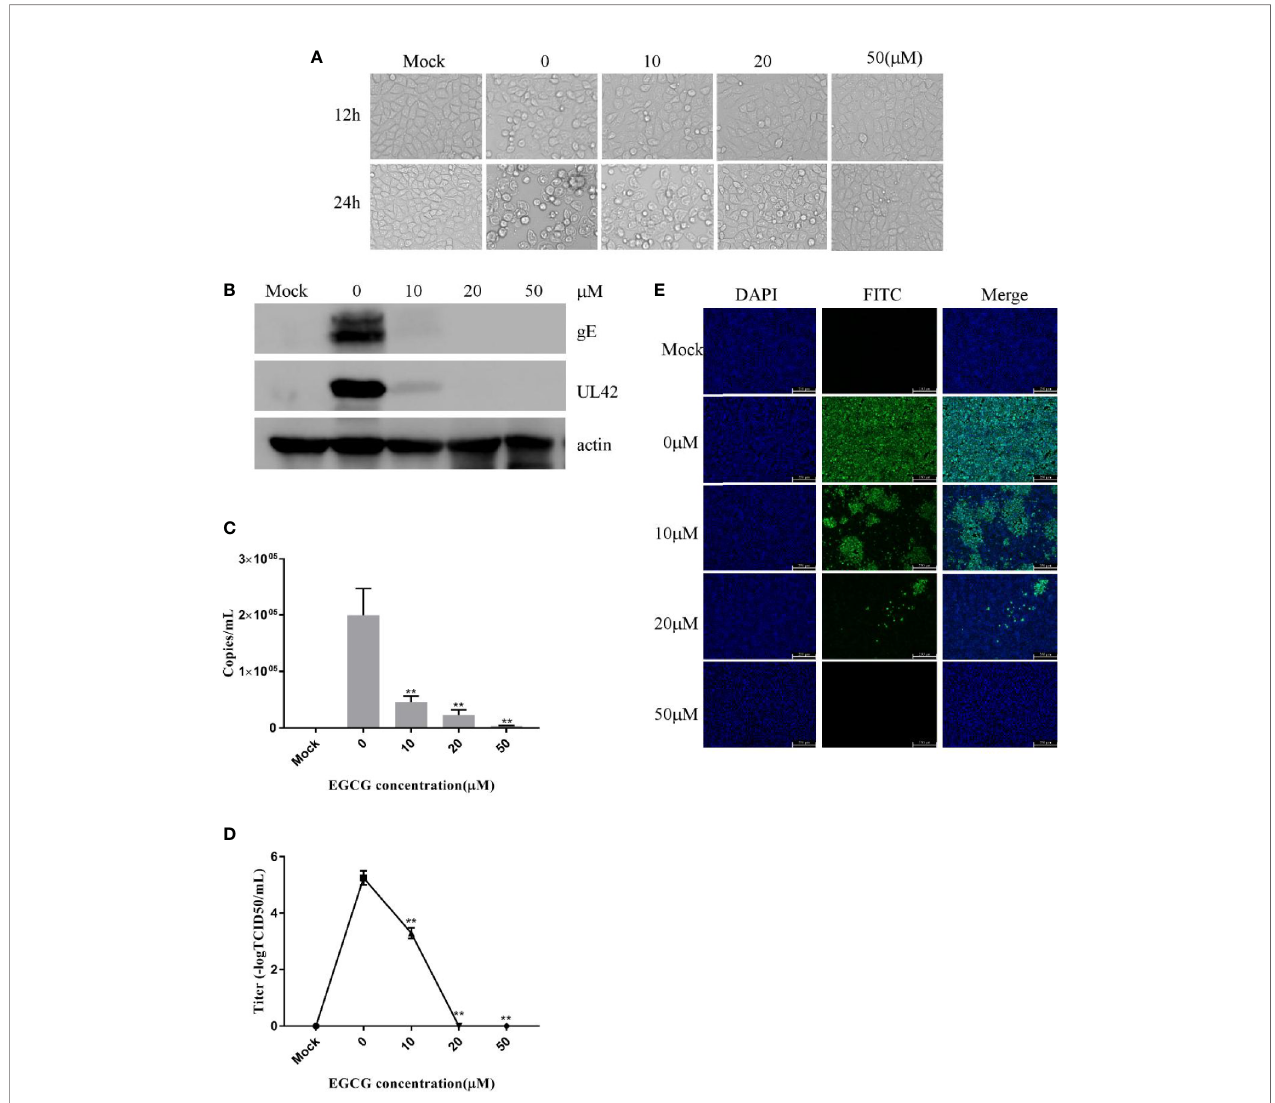
FIGURE 1 | ( – )-Epigallocatechin-3-gallate (EGCG) inhibited pseudorabies virus (PRV) infection in PK15 B6 cells. (A) Infected cells treated with 10, 20, or 50 m M EGCG for 12 or 24 h, showing changes in cell morphology. (B) PK15 B6 cells were pretreated with 10, 20, or 50 m M EGCG for 1 h before being infected with PRV XJ5 (MOI=0.1), then infected cells cultured with 10, 20, or 50 m M EGCG. At 24 hpi, gE, UL42 and b -actin proteins were detected by Western blot, (C) Viral DNA copy numbers were quanti fi ed by qRT-PCR. (D) Virus titer was evaluated by 50% tissue culture infective dose (TCID 50 ) and (E) immuno fl uorescent assay (IFA) for internalized virus was performed. **p <